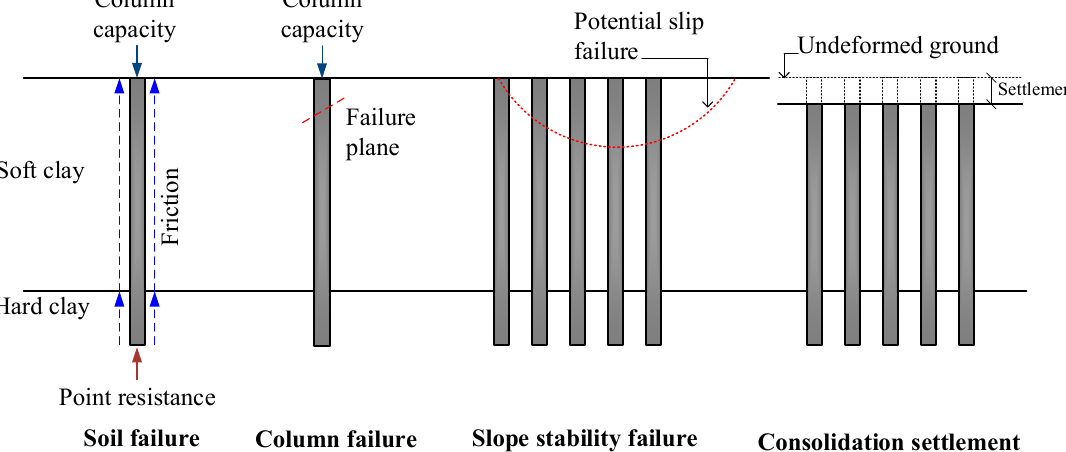
Figure 3. Various failure modes and settlement of a CFG column-supported embankment built on soft clay.